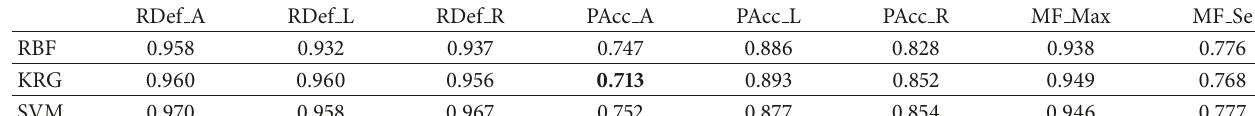
Table 6: R 2 s of 10-fold cross validation.